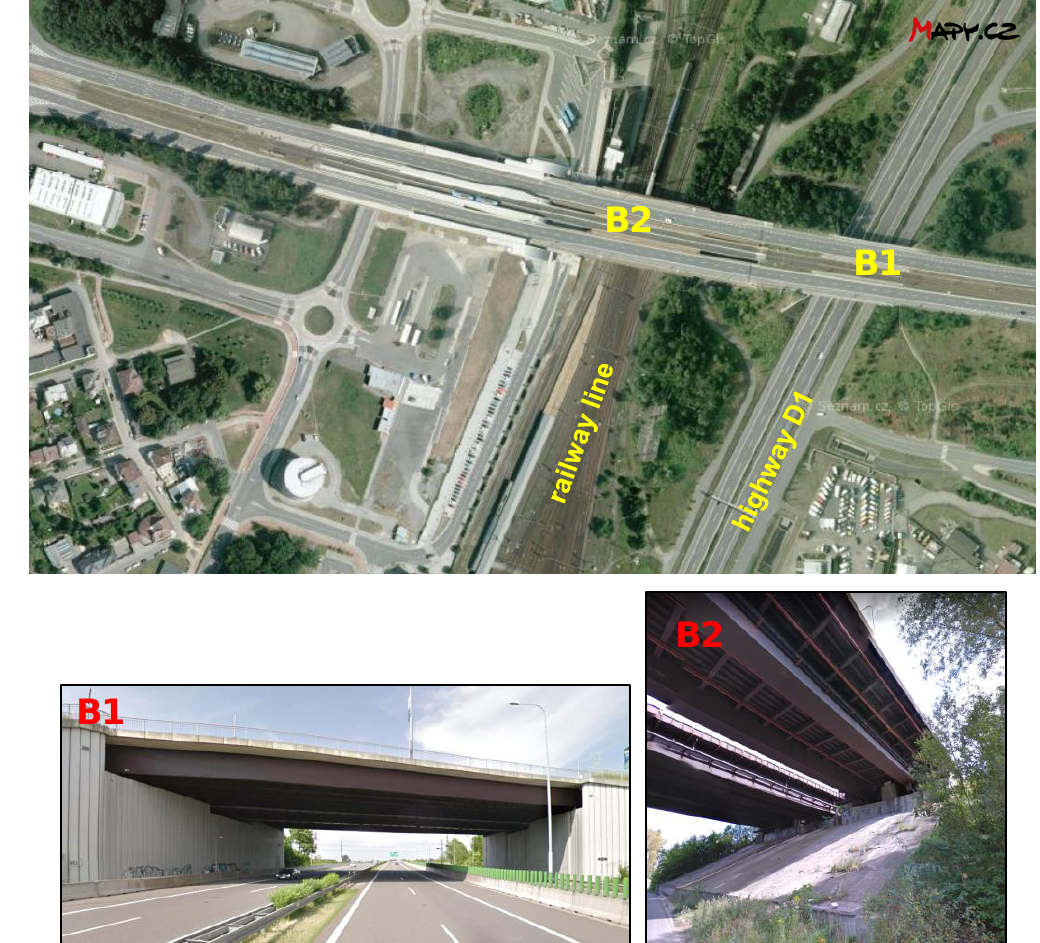
Figure 3. Location of the selected bridge structures.